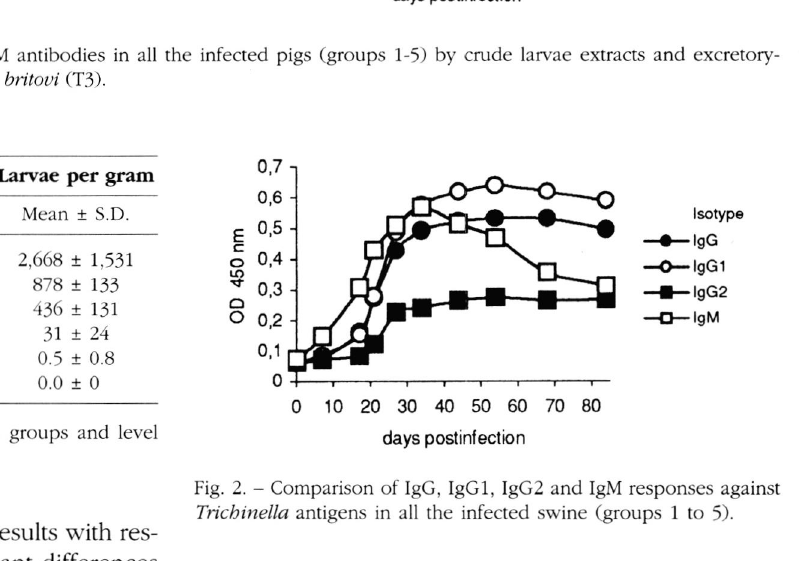
correlated significantly with the infecting doses from 17 to 84 dpi, specially at 27 for IgGl (r = 0.82), and the number of lpg, but this correlated only weakly with the IgG2 at 27 dpi (r = 0.19). IgG levels differed signi ficantly among the experimental groups, starting at 17- 27 dpi, excepting between groups 3 and 4, and finally group 2-4 at 54-68 dpi (Fig. 3). Groups 1-2 were very similar in the IgGl responses and were indistingui shable from groups 3-4 at the end of experiment. The